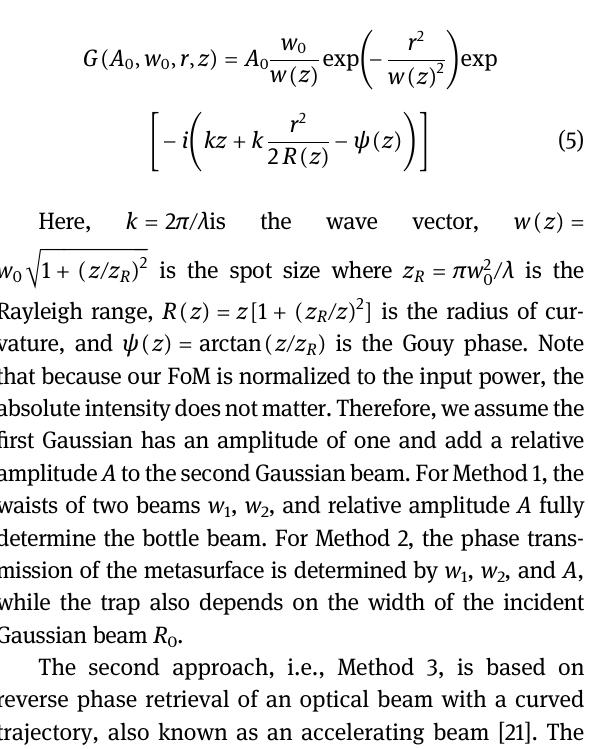
Figure 2: (a) An optical bottle beam formed by the destructive interference of two Gaussian beams with different waists and a π phase shift at the mutual focus. The radial extent (e.g., along the x axis) of the low-intensity region (trapping volume) is roughly equal to the waist of the smaller beam, and the extent along the propagation direction ( z axis) is determined by the difference in the waist-dependent Gouy phase. (b) Design of an optical bottle beam by reverse phase retrieval of an accelerating beam. Starting from the bent trajectory of an accelerating beam,onecan fi ndtheraysthatcanbethoughtofasformingthebeam,fromwhichthewavefrontcanbeconstructed.Therefore,onecanform abottlebeambycreatingthecorrespondingphaseresponse.(c)Schematicofasetupforcreatingabottlebeamusingdestructiveinterference oftwoGaussianbeamssuperimposedusingabeamsplitter.(d)Schematicof asetupforcreatingabottlebeamusingasingleGaussianbeam incident on a metasurface with an appropriate phase